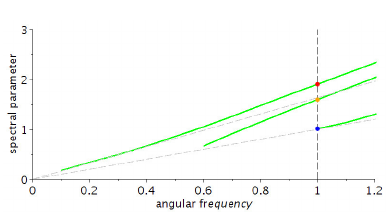
Figure 7. The dependence of spectral parameter γ with respect to m in case of ω = 1. Red and blue colours corresponds to ε c + ρ − 2 and ε c , respectively. 2